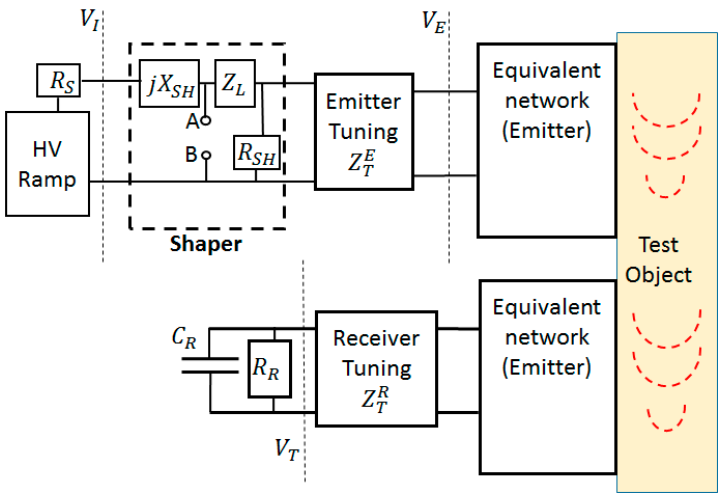
Figure 10. Equivalent circuit diagram representing the tuning of a piezoelectric transceiver for excitation and reception in a pitch-catch mode [131].